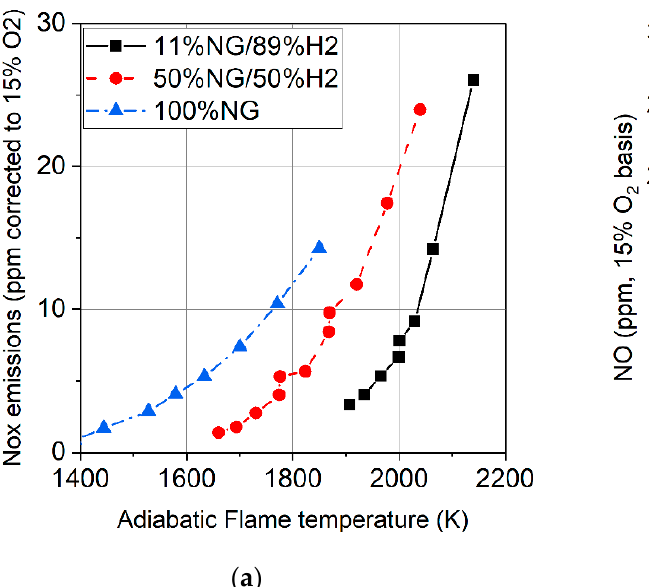
Figure 19. The relationship between the NO emissions of natural gas and hydrogen and the volume fraction of hydrogen.